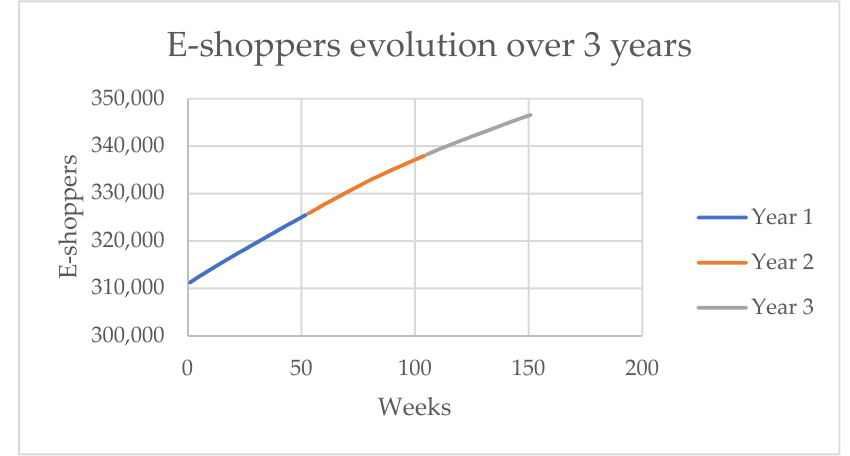
Figure 2. E-shoppers evolution over 3 years.